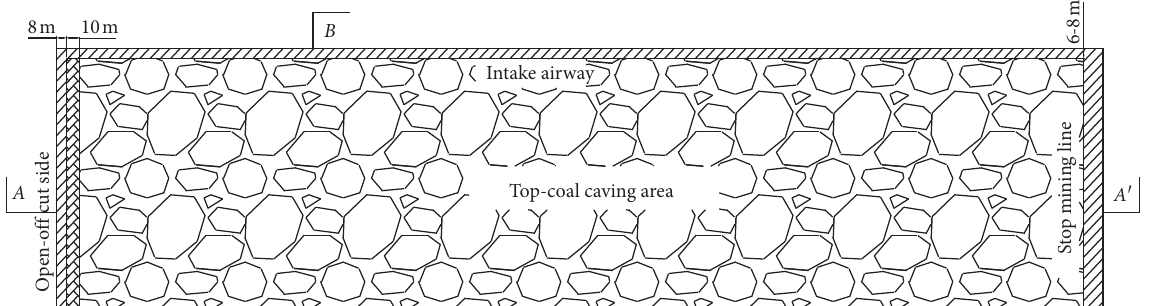
Figure 1: Working face layout.